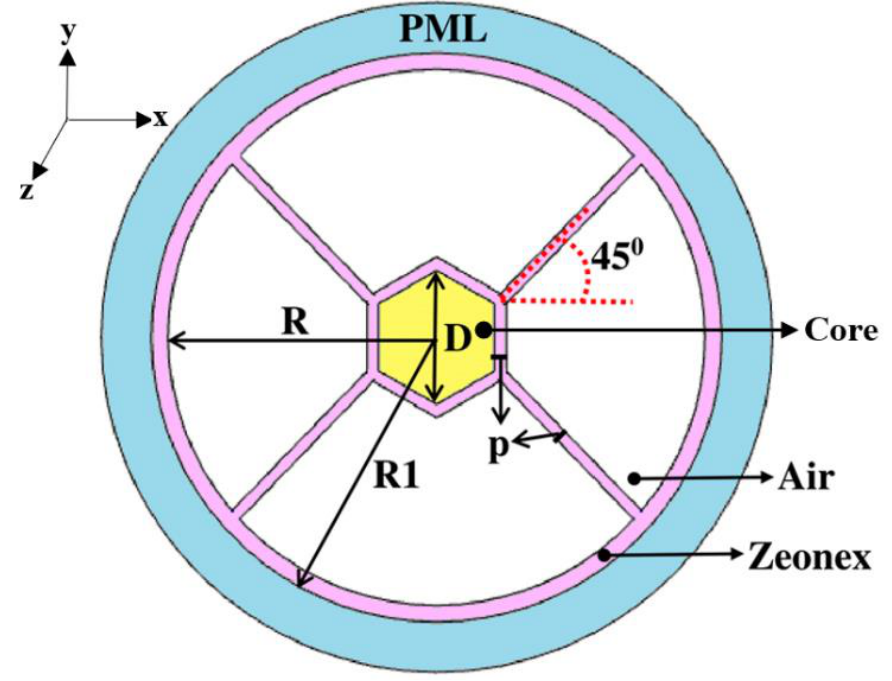
Figure 1. The suggested PCF-based edible oil detection sensor in two dimensions.